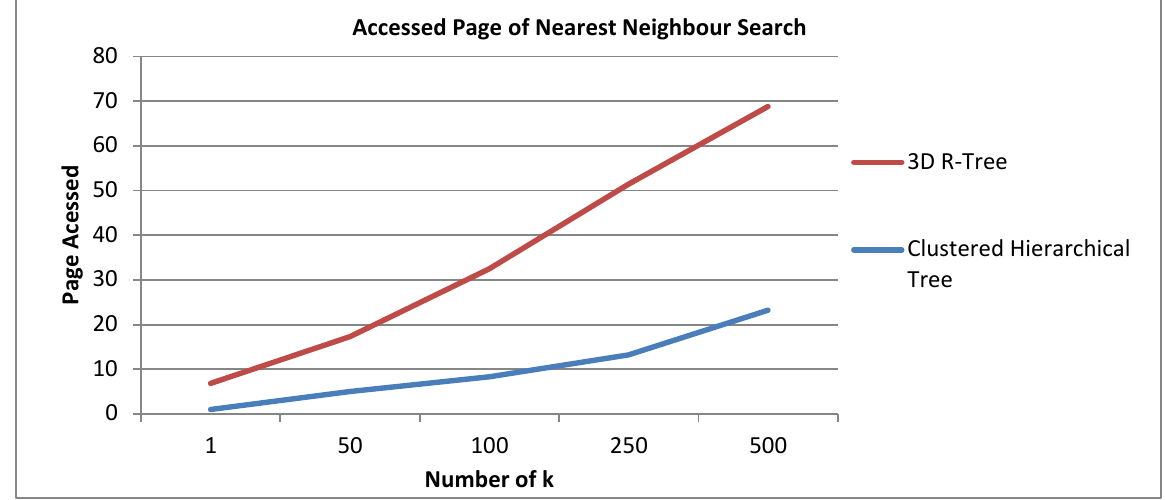
Figure 4. Accessed page of nearest neighbor search